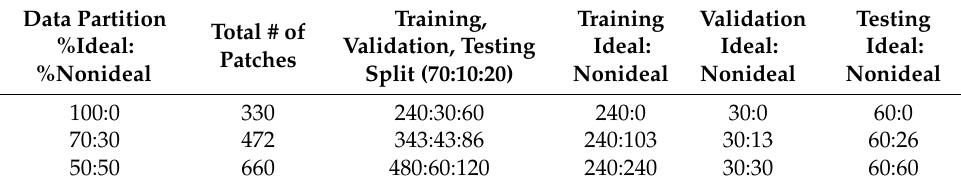
Table 4. Number of images used for each data split partition on SMH ROIs.